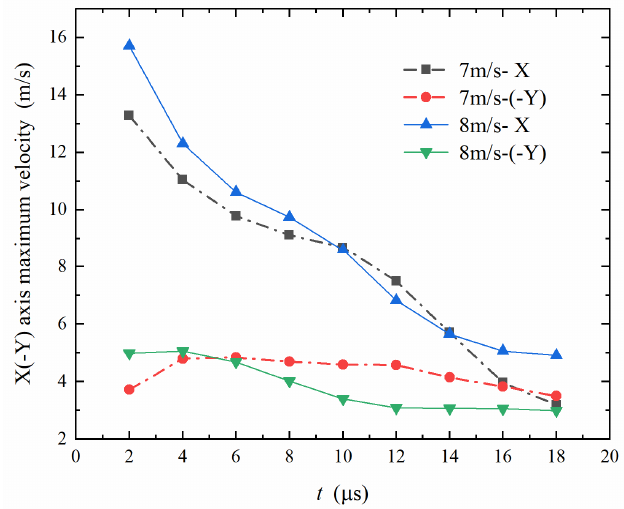
Figure 15. Variation in maximum velocity of X/(-Y) axis with time.